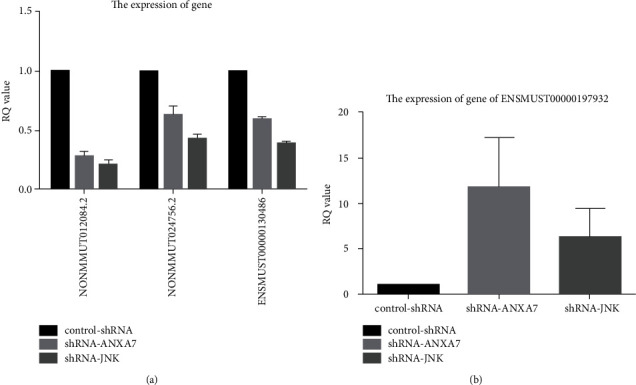
(a) Relative expression levels of the lncRNAs NONMMUT012084.2, NONMMUT024756.2, and ENSMUST00000130486 measured by qRT-PCR following stable transfection of Hca-P cells with control-shRNA, shRNA-ANXA7, or shRNA-JNK (P < 0.05). (b) Relative expression level of ENSMUST00000197932 (P < 0.05).